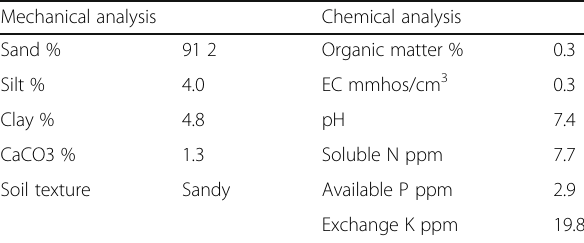
Table 1 Mechanical and chemical analyses of the experimental soil (2012 – 2013 and 2013 – 2014 seasons)